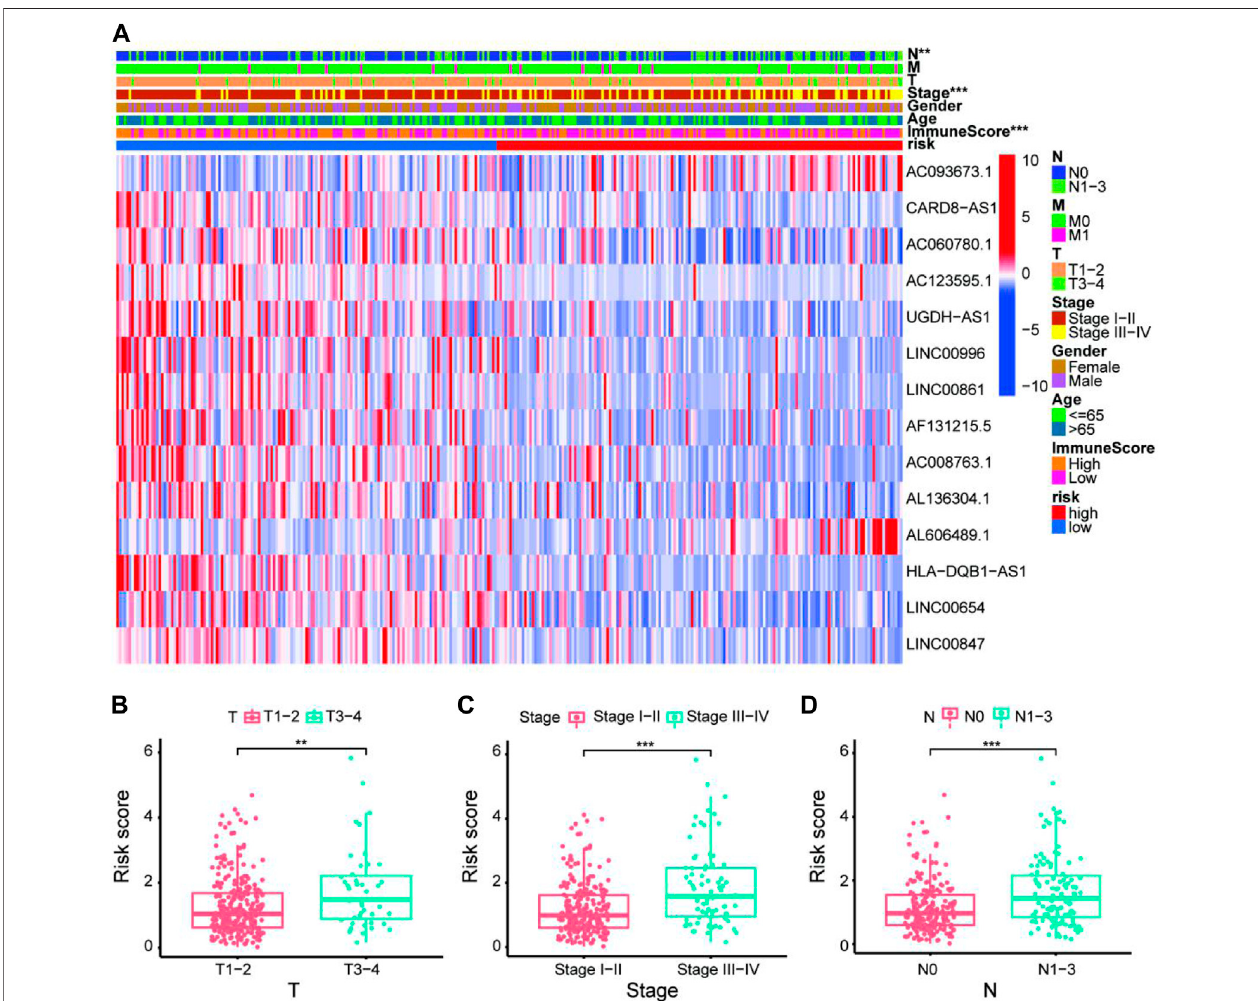
FIGURE5| Explorationofclinicopathologicalcharacteristicsofthe14-ARlncRNAsignature. (A) Theheatmapsuggestedthatstage( p < 0.001),ImmuneScore( p < 0.001),andN( p < 0.01)werestatisticallydifferentindifferentgroups.Inaddition,mostARlncRNAsincludedinthemodelingprocesswereenrichedinthelow-riskgroup, suggesting that autophagy was more active in the low-risk group. (B – D) The scatter diagrams indicated that patients with LUAD with advanced T, advanced stage, or advanced N tended to have higher-risk score and statistically signi fi cant.